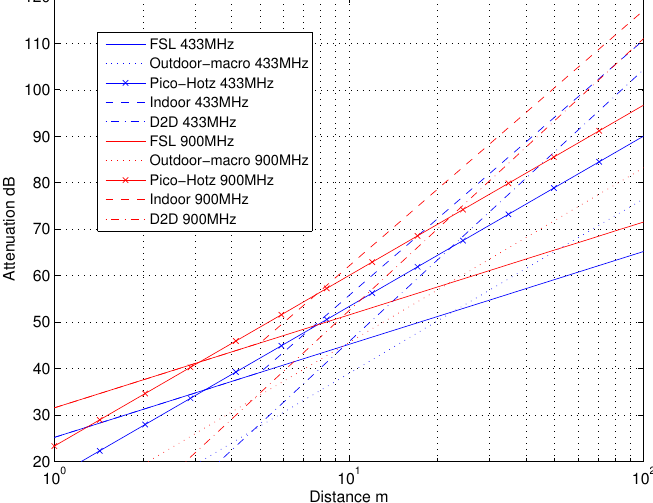
Figure 5. Path losses for considered 802.11ah channels at 433 MHz and 900 MHz bands. Here d BP = 5 for indoor channel. Free space loss, FSL, is also shown for